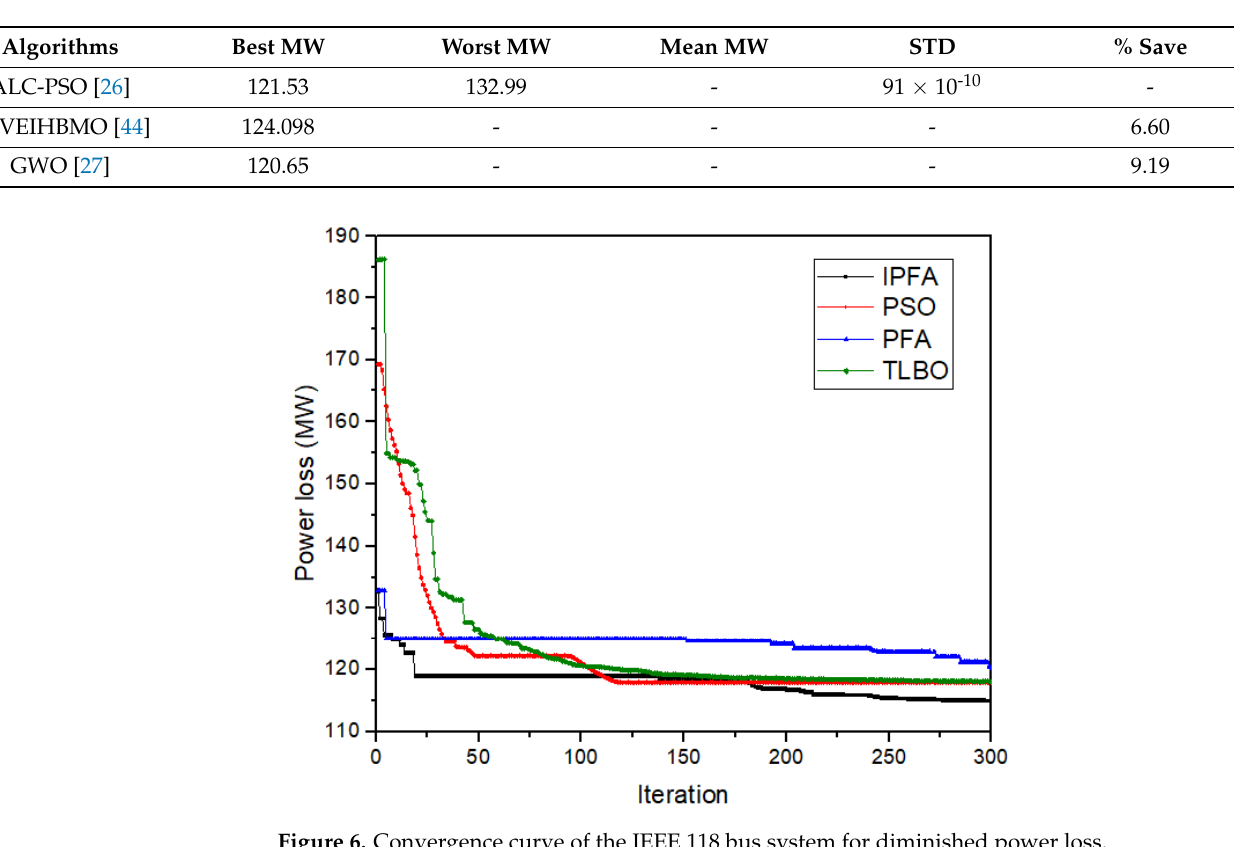
Figure 6. Convergence curve of the IEEE 118 bus system for diminished power loss. Table 5. Comparison with other techniques.